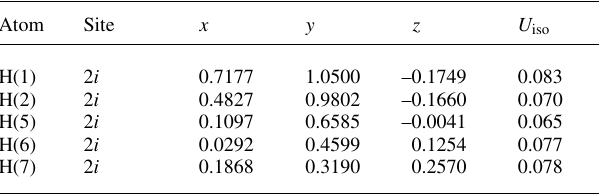
Table 2. Atomic coordinates and displacement parameters (in Å 2 )